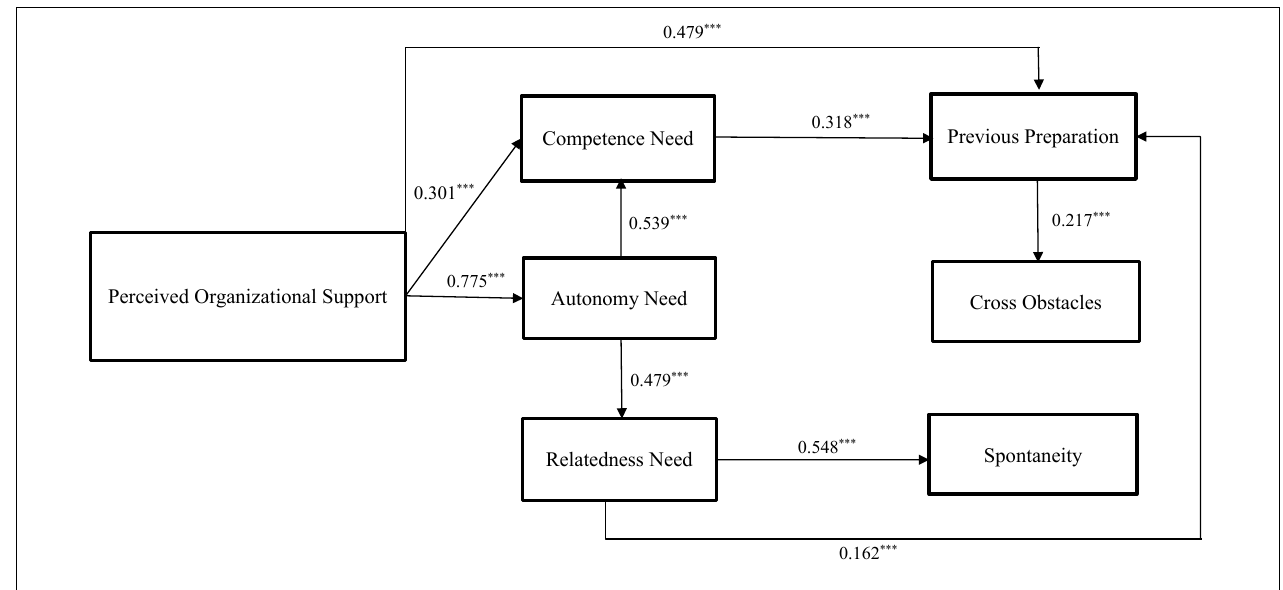
FIGURE 2 | Results of the structural equation. ***indicates p < 0.001.